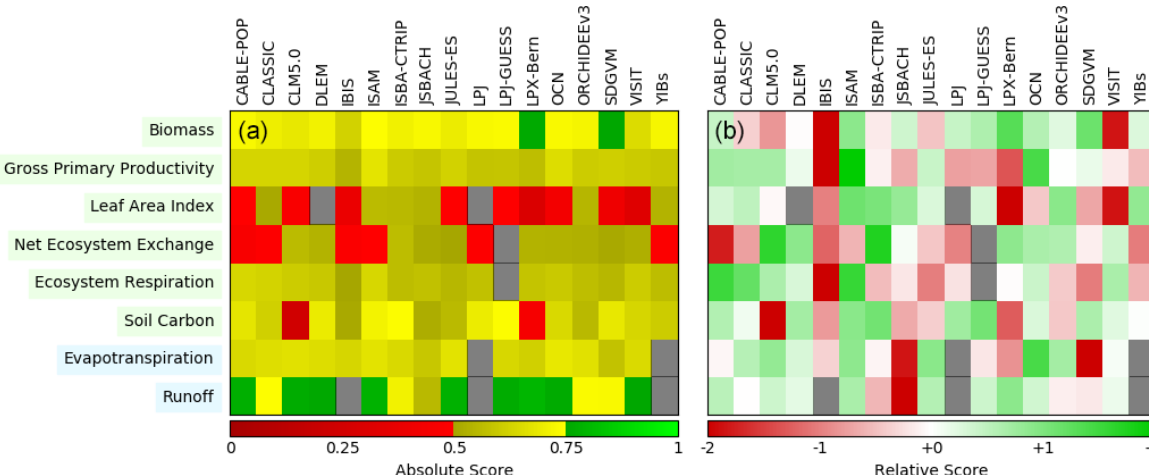
Figure B2. Evaluation of the DGVM using the International Land Model Benchmarking system (ILAMB; Collier et al., 2018) (a) absolute skill scores and (b) skill scores relative to other models. The benchmarking is done with observations for vegetation biomass (Saatchi et al., 2011; GlobalCarbon unpublished data; Avitabile et al., 2016), GPP (Jung et al., 2010; Lasslop et al., 2010), leaf area index (De Kauwe et al., 2011; Myneni et al., 1997), net ecosystem exchange (Jung et al., 2010; Lasslop et al., 2010), ecosystem respiration (Jung et al., 2010; Lasslop et al., 2010), soil carbon (Hugelius et al., 2013; Todd-Brown et al., 2013), evapotranspiration (De Kauwe et al., 2011), and runoff (Dai and Trenberth, 2002). For each model–observation comparison a series of error metrics are calculated, scores are then calculated as an exponential function of each error metric, and finally for each variable the multiple scores from different metrics and observational data sets are combined to give the overall variable scores shown in (a) . Overall variable scores increase from 0 to 1 with improvements in model performance. The set of error metrics vary with data set and can include metrics based on the period mean, bias, root mean squared error, spatial distribution, interannual variability and seasonal cycle. The relative skill score shown in (b) is a Z score, which indicates in units of standard deviation the model scores relative to the multi-model mean score for a given variable. Grey boxes represent missing model